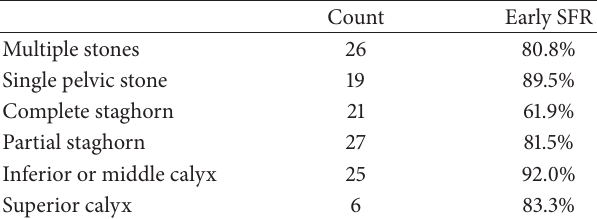
Table 4: Early SFR in relation to the stone